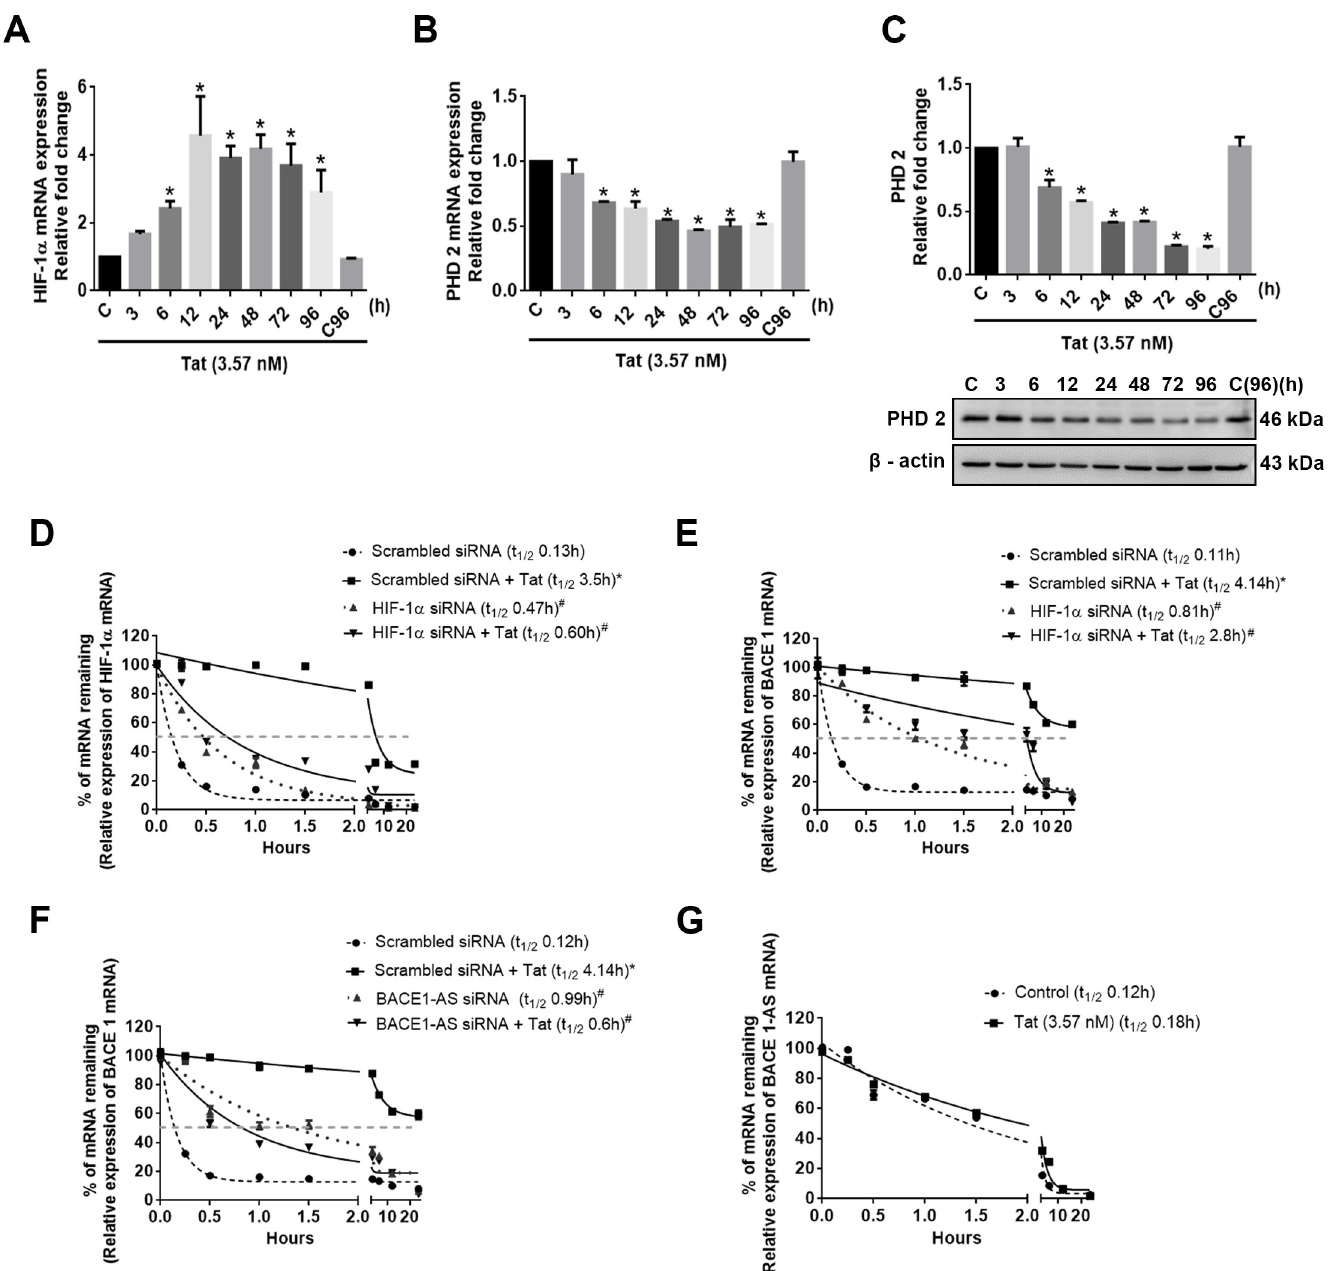
Fig 10. Molecular mechanism(s) involved in HIV-1 Tat–mediated up-regulation of HIF-1 α in HPAs. (A) qPCR showing expression of HIF-1 α mRNA in HPAs exposed to HIV-1 Tat (3.57 nM) at the indicated time points. (B) qPCR showing expression of PHD-2 in HPAs exposed to HIV-1 Tat (3.57 nM) at the indicated time points. GAPDH was used as an internal control for mRNA expression. (C) Representative western blot showing time-dependent down-regulation of PHD-2 in HPAs exposed to HIV-1 Tat at the indicated time points. β -actin was used as an internal control. (D) Regression analysis showing stabilization of HIF-1 α mRNA in HPAs transfected with either scrambled or HIF-1 α siRNA in the presence or absence of HIV-1 Tat. (E) Regression lines showing mRNA stabilization and indicating the half- lives of BACE1 in HPA transfected with scrambled/HIF-1 α siRNA, with/without HIV-1 Tat exposure. (F) Regression lines showing mRNA stabilization and indicating the half-lives of BACE1 in HPA transfected with scrambled/BACE1-AS siRNA, with/without HIV-1 Tat exposure. (G) Regression lines showing mRNA stabilization and indicating the half-lives of BACE1-AS in HPA with/without HIV-1 Tat exposure. Data are presented as mean ± SEM; n = 6. One-way ANOVA followed by Bonferroni post hoc test was used to determine the statistical significance between multiple groups: � P < 0.05 versus control, # P < 0.05 versus Tat. The data underlying this figure may be found in S10 Data. BACE1, β -site cleaving enzyme; BACE1-AS, BACE1-antisense transcript; GAPDH, glyceraldehyde 3-phosphate dehydrogenase; HIF-1 α , hypoxia-inducible factor; HPA, human primary astrocyte; PHD-2, prolyl hydroxylase 2; qPCR, quantitative polymerase chain reaction; siRNA, small interfering RNA; Tat, transactivator of transcription.